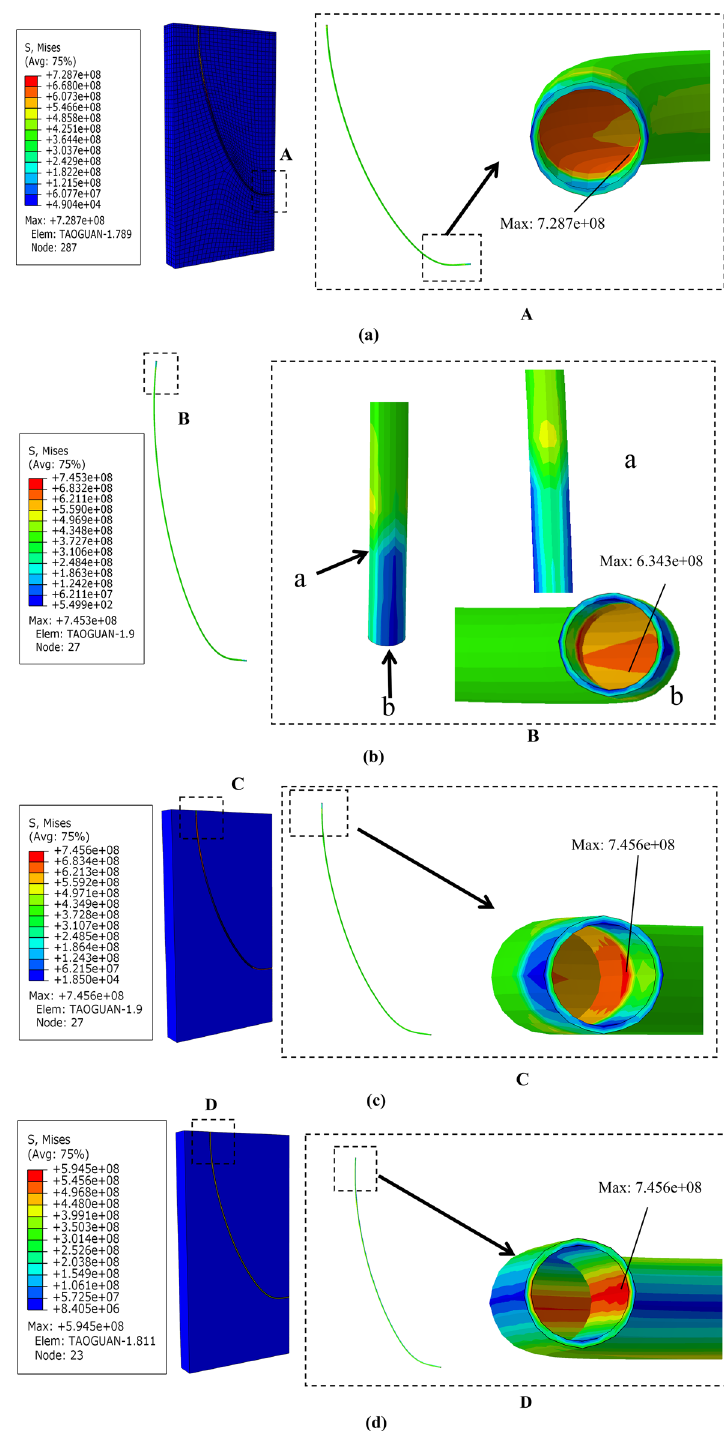
Fig. 9 The cloud map of cas- ing tensile stress distribution under different missing parts of cement. a Absence of tilting area. b Absence of central